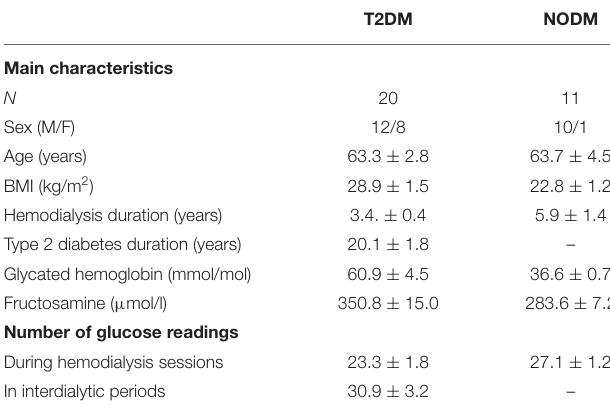
TABLE 1 | Main characteristics of the patients, and number of glucose readings during the 14 days wearing period of the FGM sensor (mean ±